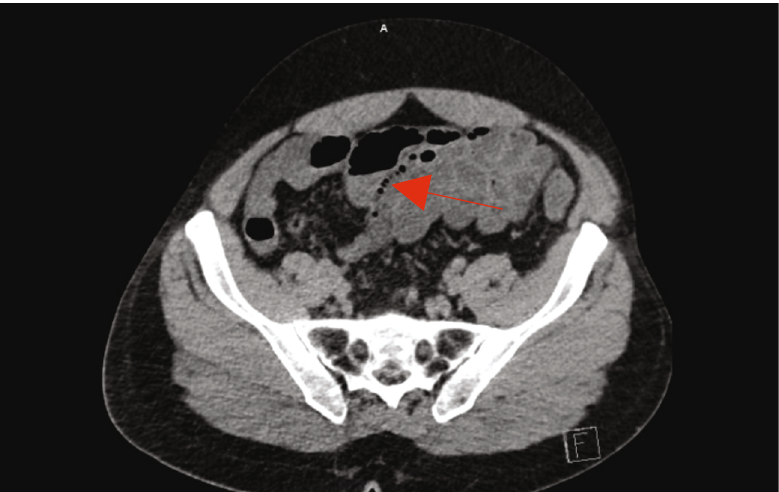
Figure 2: Bowel wall thickening with